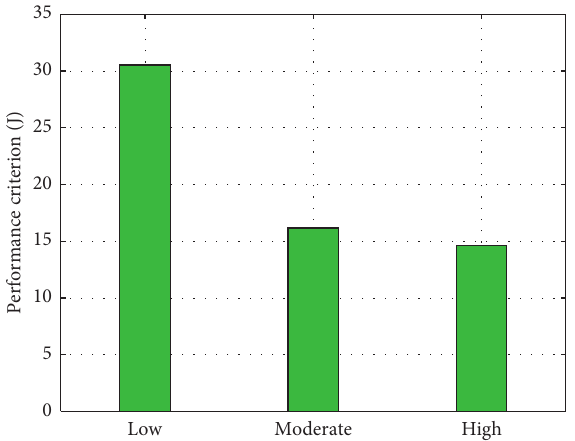
Figure 6: Performance